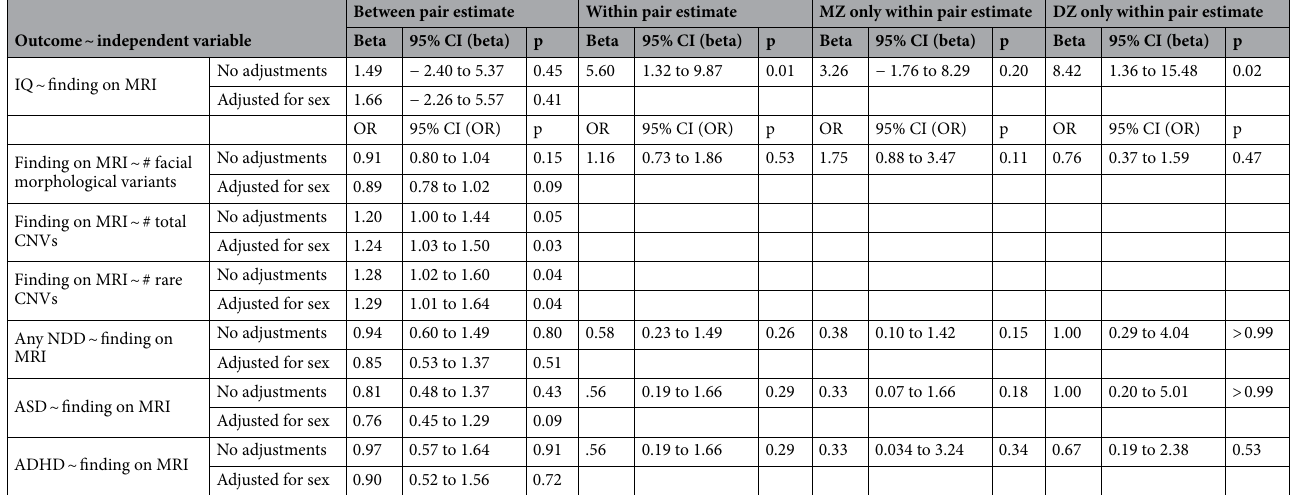
Table 3. Between and within pair associations: neuroradiological findings on MRI, facial morphological variants, copy number variants, and neurodevelopmental disorder diagnoses. OR odds ratio, # Number, IQ intelligence quotient, ASD Autism Spectrum Disorder, ADHD attention–deficit/hyperactivity disorder, NDD neurodevelopmental disorder, CNVs copy number variants, MZ monozygotic, DZ dizygotic. Table presents the associations between dimensional and categorical variables and finding(s) on MRI. Sex was adjusted for in each of the analyses due to the statistically significant difference in MRI findings by sex; however, in within pair analyses, all factors shared between pairs are adjusted for, thus the estimate is already adjusted for sex since only same-sexed pairs are analyzed. A statistically significant association exists between the total number of CNVs and rare CNVs and a finding on an MRI, so that increasing numbers of CNVs and rare CNVs were associated with the presence of MRI findings. This appears to be an error in the table footnote. For some analyses, within-pair estimates, including within-pair estimates split by MZ or DZ twin pairs, were not conducted due to the small sample sizes and lack of variability in outcomes for the twin participants. Using a simultaneous Wald test, both ASD and ADHD diagnoses were statistically significantly correlated with the presence of increasing numbers of facial morphological variants, numbers of CNVs, and presence of MRI findings (p = 0.0006 for ASD, p = 0.002 for ADHD). However, no relationship was found between these variables and the diagnosis of any NDD as an overarching diagnostic category (p =